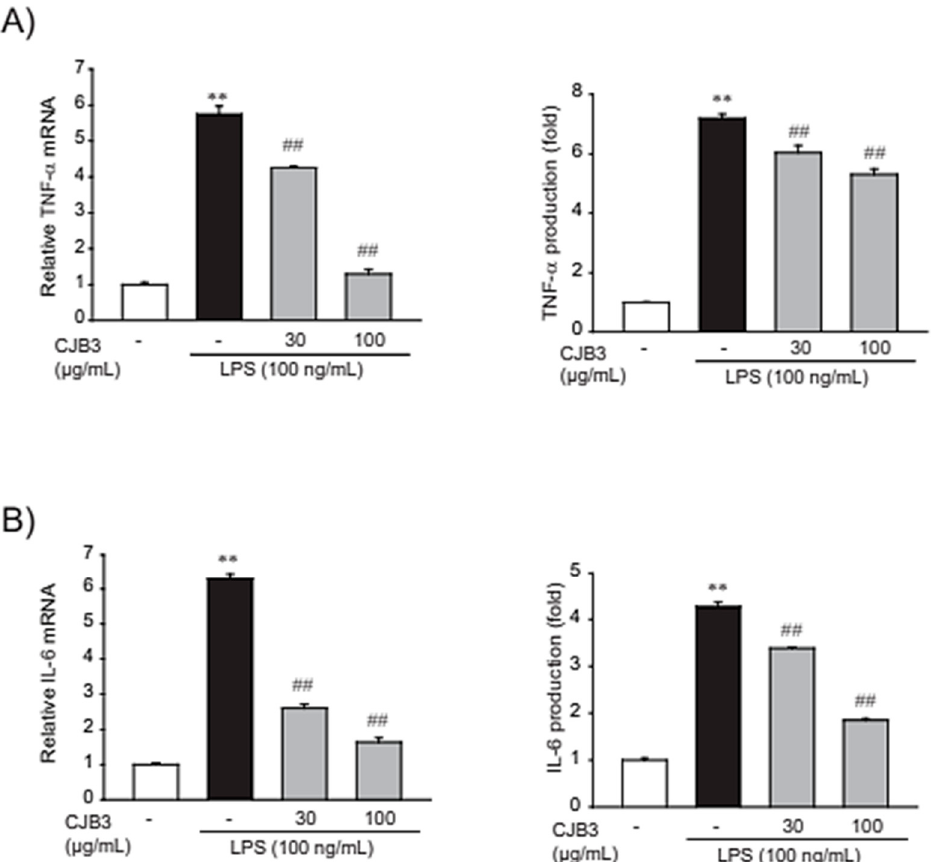
Figure 6. CJB3-mediated inhibition of LPS-induced proinflammatory cytokine expression. ( A , B ) Measurement of the inhibitory effect of CJB3 on proinflammatory cytokine expression: cells were treated with 30 or 100 μ g/mL CJB3 for 1 h and incubated with LPS for 6 h. ( A ) Tumor necrosis factor- alpha (TNF- α ) and interleukin-6 (IL-6) transcripts were monitored using RT-PCR assays. ( B ) Enzyme-linked immunosorbent assay (ELISA): TNF- α and IL-6 release into the culture supernatant was determined using ELISA. Data are expressed as the mean ± SE of three replicates; ** p < 0.01, significant vs. vehicle-treated control; ## p < 0.01, significant vs. LPS alone.